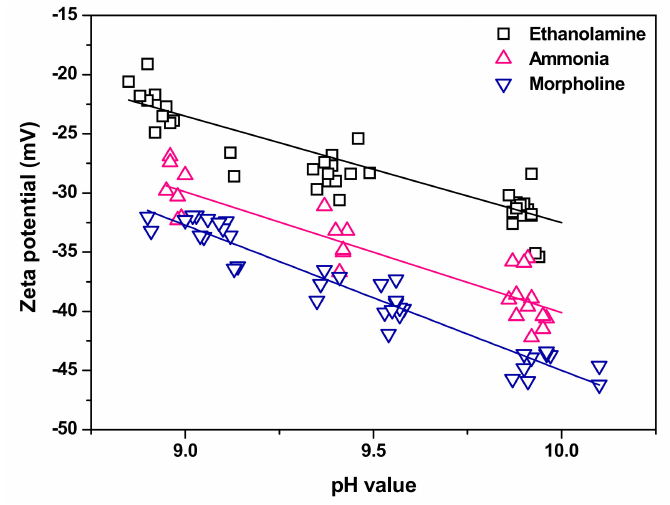
Figure 3. Zeta potentials of magnetite nanoparticles as a function of pH value, controlled with ethanolamine (ETA), ammonia, or morpholine at 25 ◦ C.